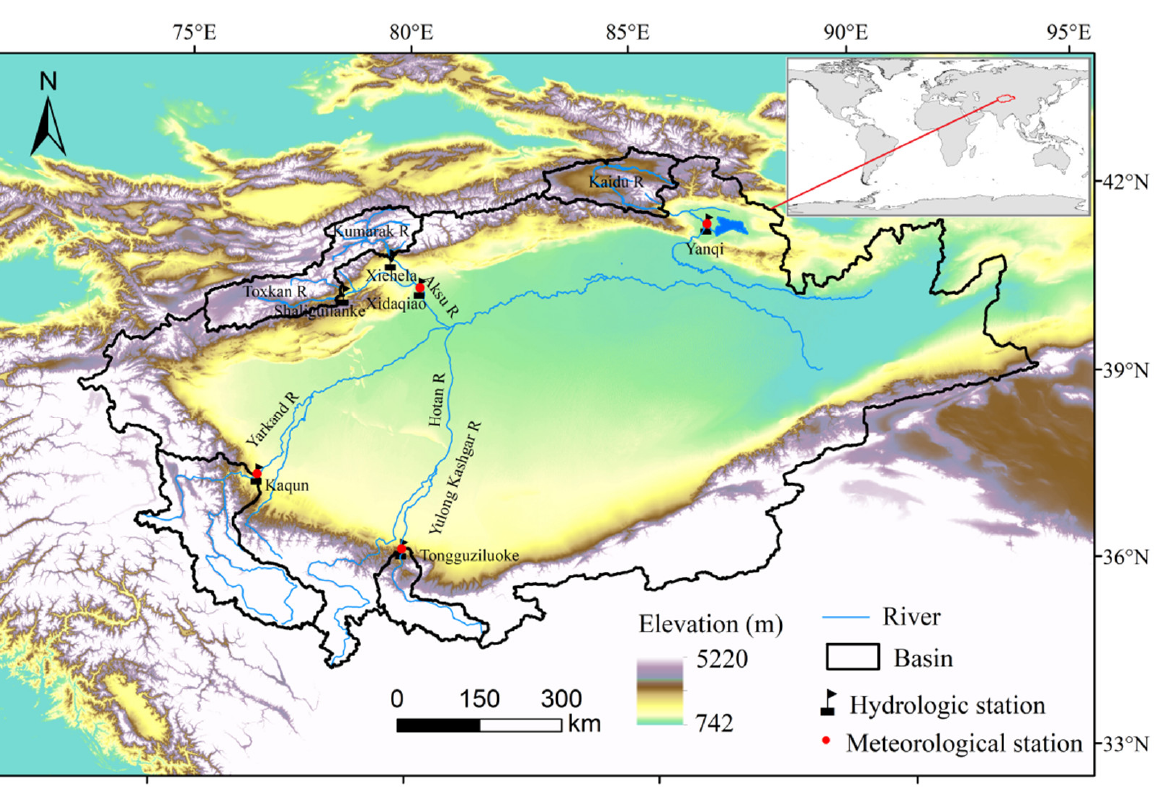
Figure 1. Study area of the Tarim River Basin. Note: The letter R means river.